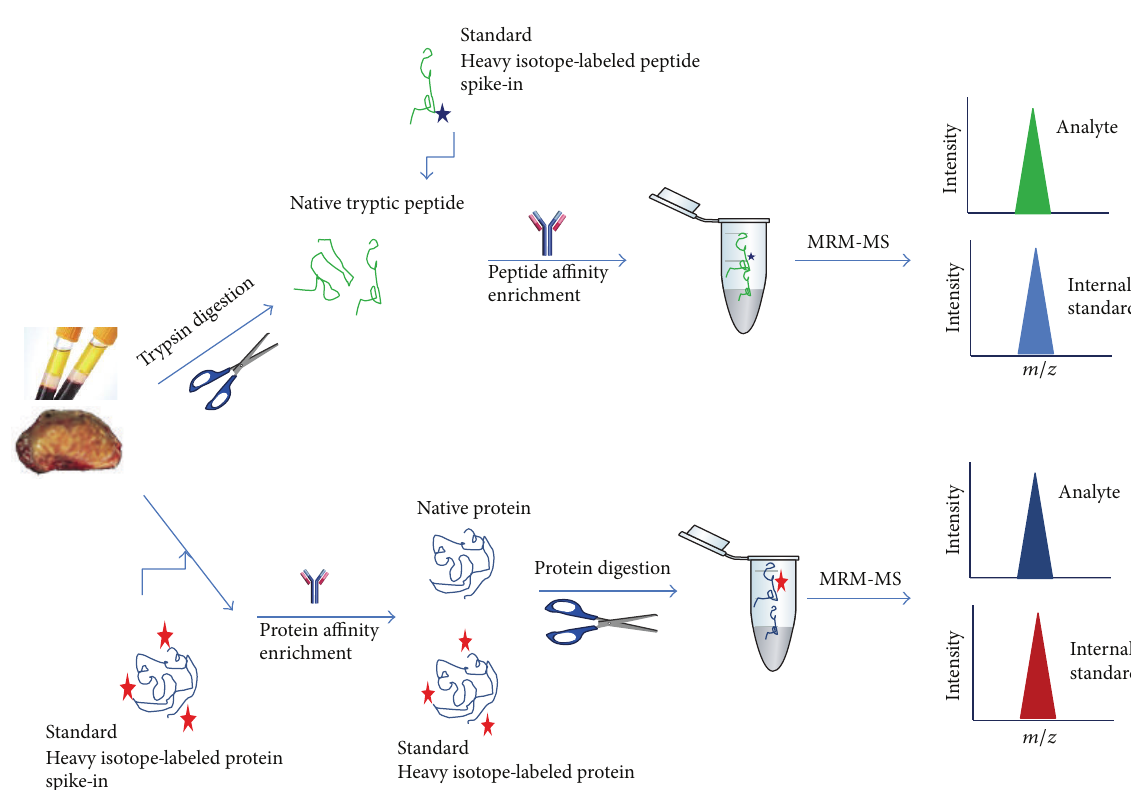
Figure 4: MRM-MS-based assay workflows ( ± immunoaffinity enrichment of proteins or peptides). SISCAPA workflow using proteolytic peptides as surrogates for their respective proteins, as illustrated in the top panel of the schematic, is a sensitive approach to measure protein concentrations using immunoaffinity enrichment of surrogate peptides prior to MRM-MS. To achieve quantitation of the targeted protein(s), they are digested to component peptides using an enzyme such as trypsin. A stable isotope standard (SIS, blue asterisk) is added to the sample at a known concentration for quantitative analysis. The selected peptides are then enriched using anti-peptide antibodies immobilized on a solid support. Following washing and elution from the anti-peptide antibody, the amount of surrogate peptide is measured relative to the stable isotope standard using targeted mass spectrometry. Alternatively, an assay can start with immunoaffinity enrichment of intact target proteins from biospecimens using an internal stable isotope-labeled protein standard (red asterisk, such as PSAQ approach) and an antibody, as illustrated in the bottom panel, followed by proteolysis and final quantitation of the